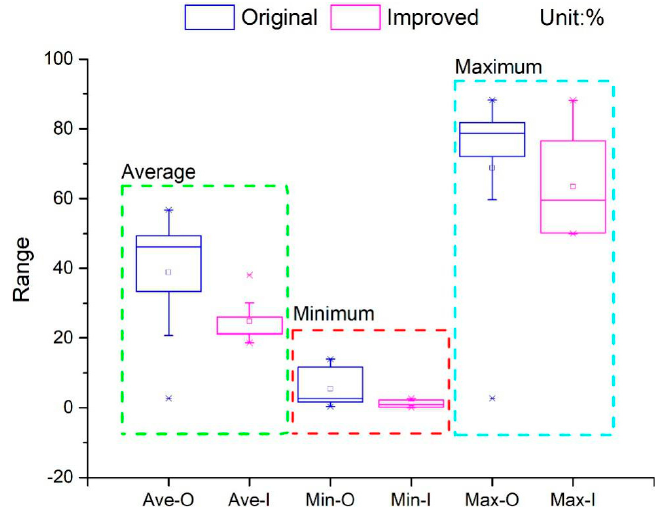
Figure 8. Comparison of water shortage range of the Nen River basin.